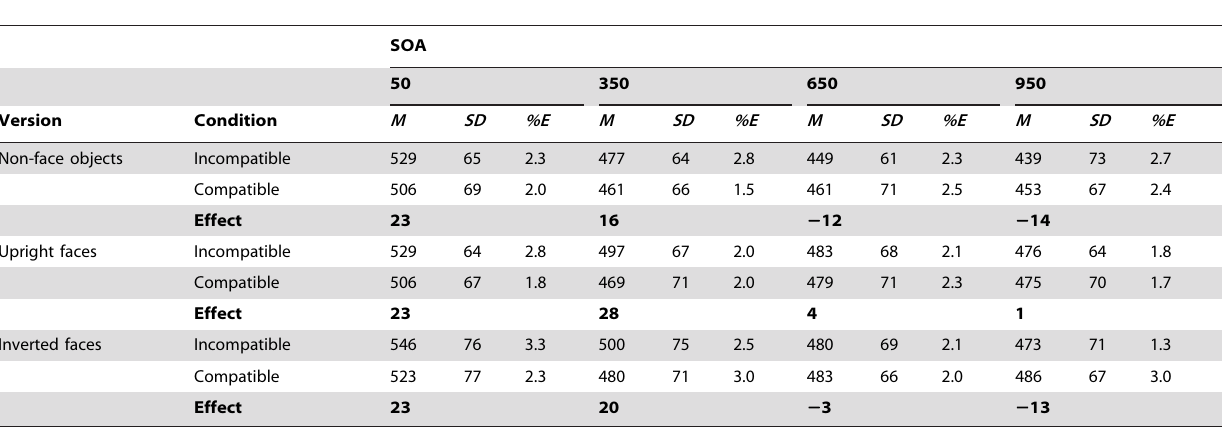
Table 1. Mean ( M ) and Standard Deviation ( SD ) of the Median Reaction Times (in ms) and Error Rates ( %E ) for Each Condition.